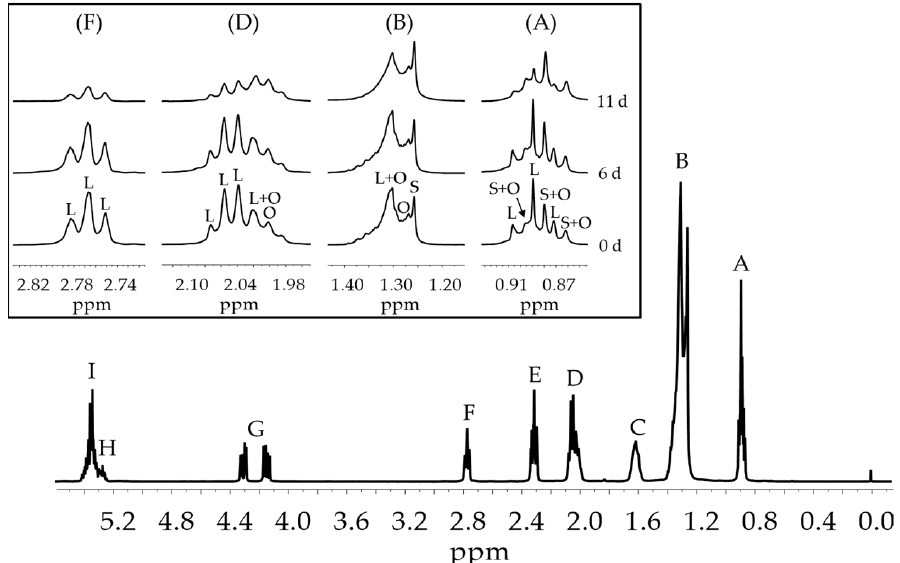
Figure 1. 1 H NMR spectra of sunflower oil S, and the enlargement of signals A, B, D and F, after being